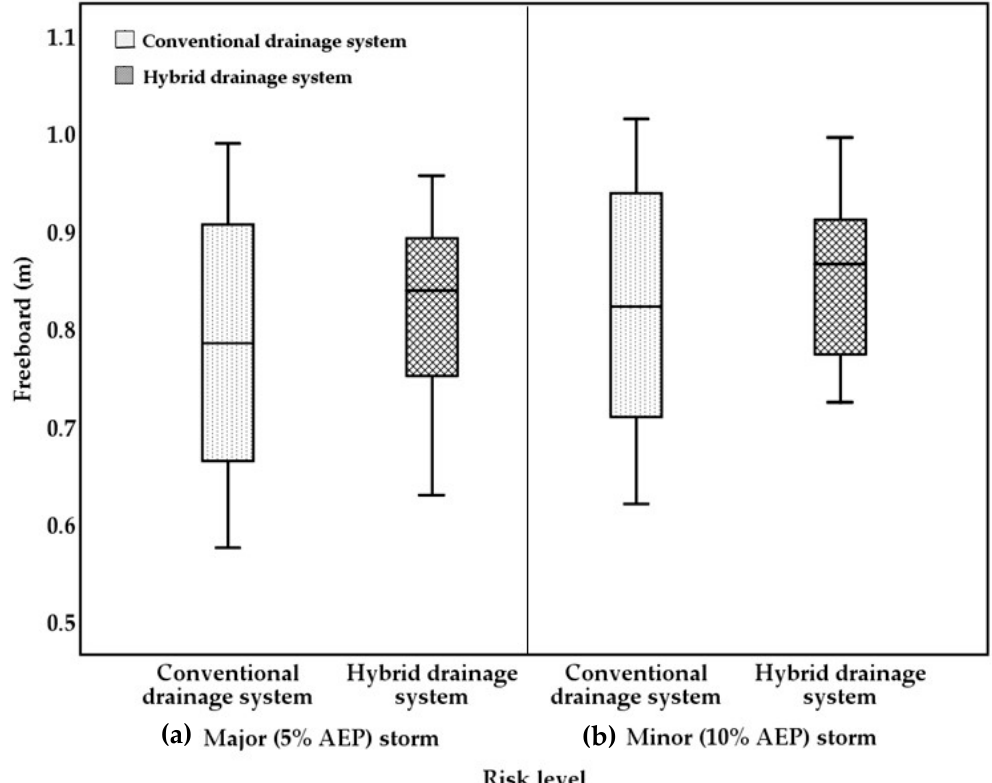
Figure 4. Freeboard variation determined for conventional and hybrid drainage systems for ( a ) 5% and ( b ) 10% annual exceedance probability (AEP) storm events.